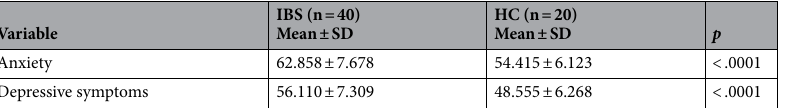
Table 2. Difference in anxiety and depression scores between IBS and healthy control (HC) groups. IBS, irritable bowel syndrome; HC, healthy control.